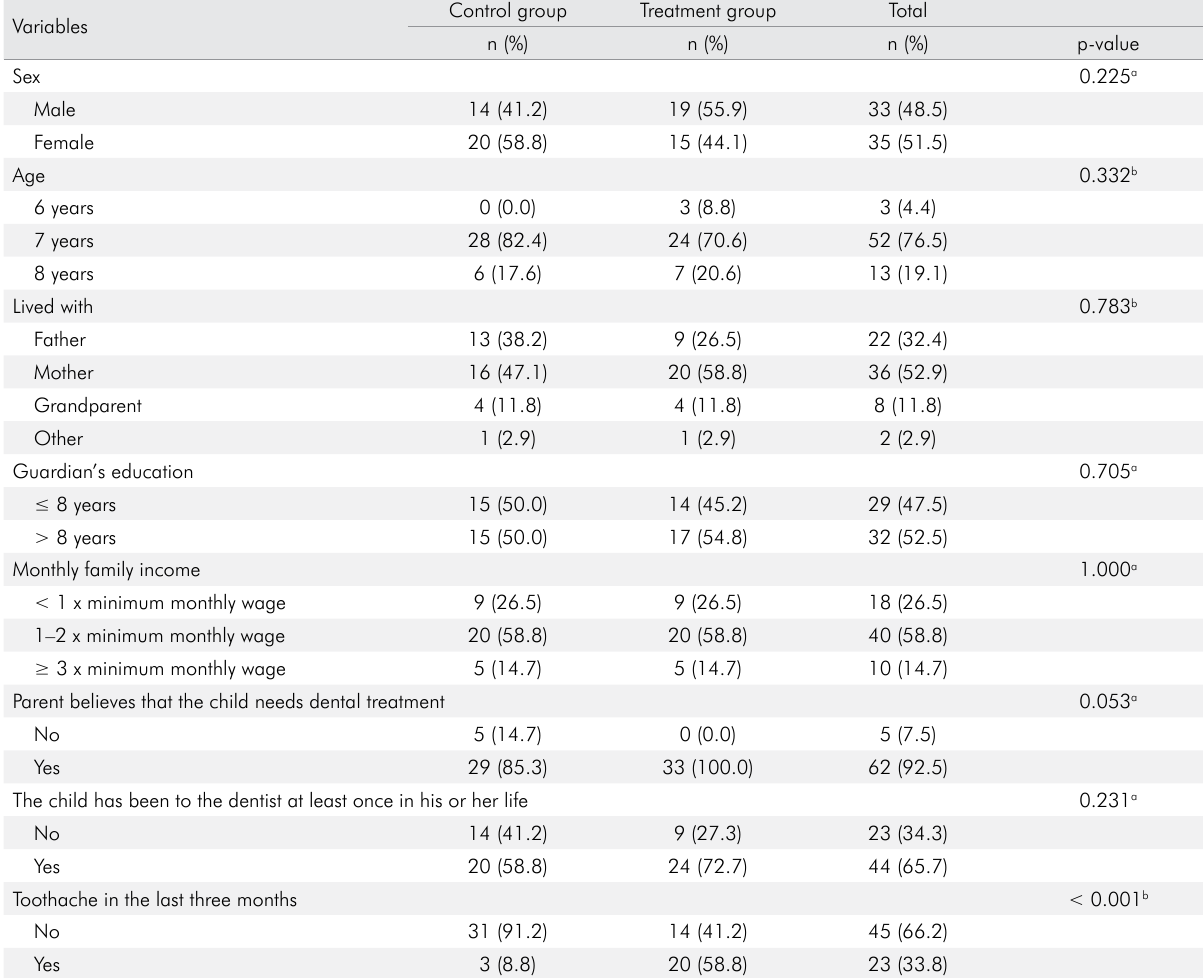
Table 1. Sample characterization according to the study groups (control and